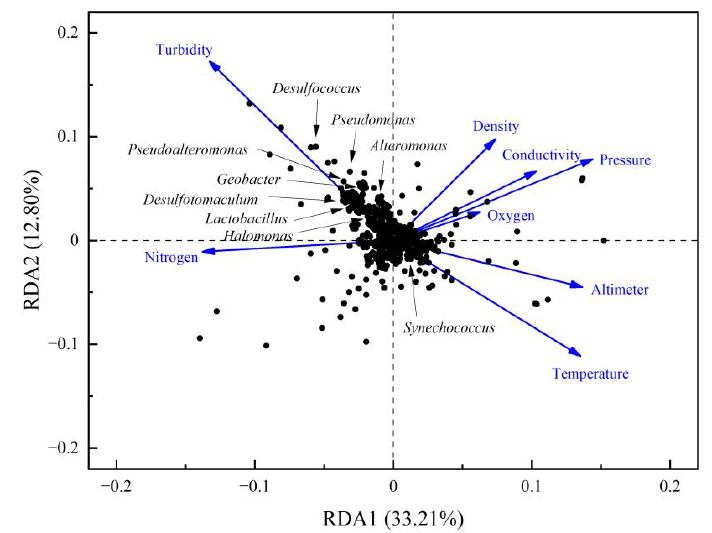
Figure 11. Redundancy analysis of bacterial communities at the genus level in the Yellow Sea.